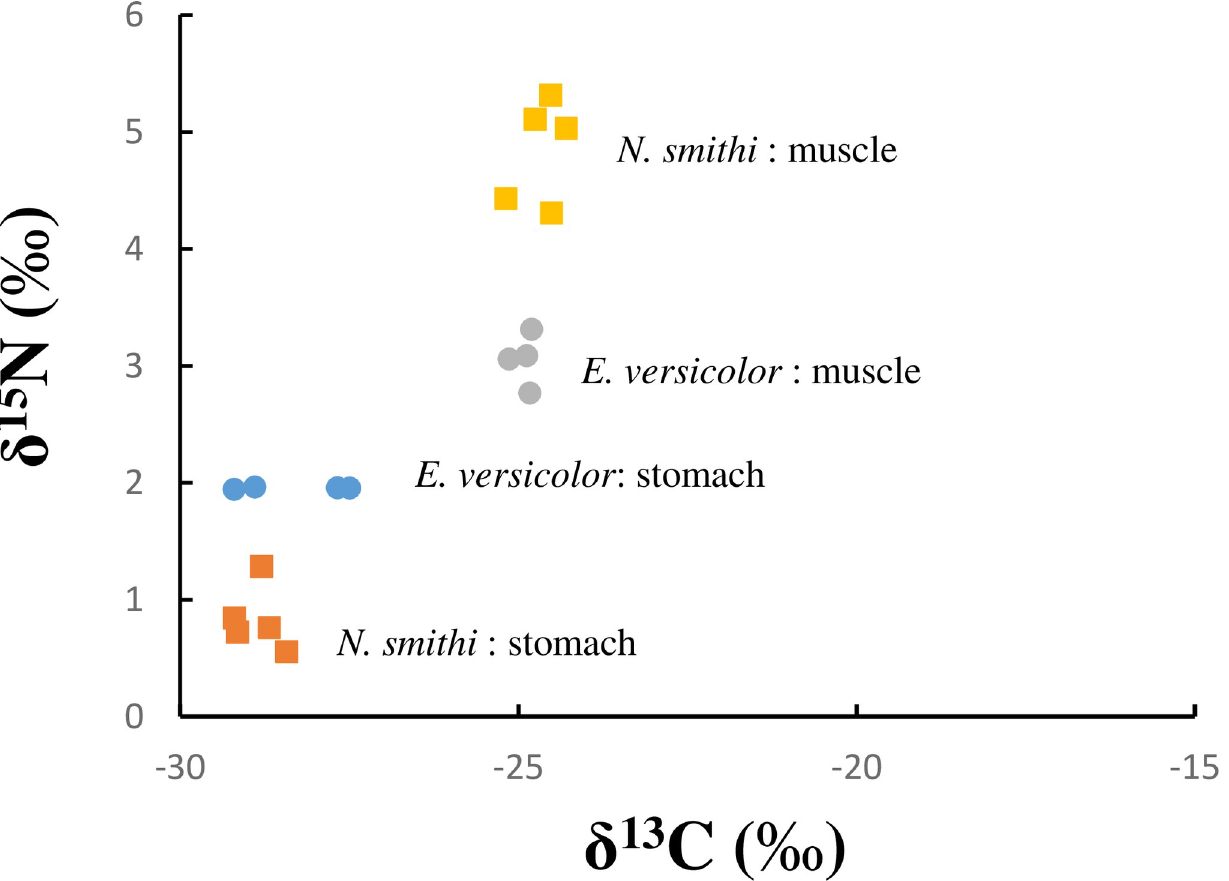
Fig 7. Stable isotope analysis. The X and Y axis show δ 13 C and δ 15 N values, respectively, of sesarmid crab stomach content and muscle. The symbols represent N . versicolor stomach contents (blue circle) and muscle (gray circle), and N . smithi stomach contents (orange square) and muscle (yellow square). The statistical analysis was performed using Student’s t-test.